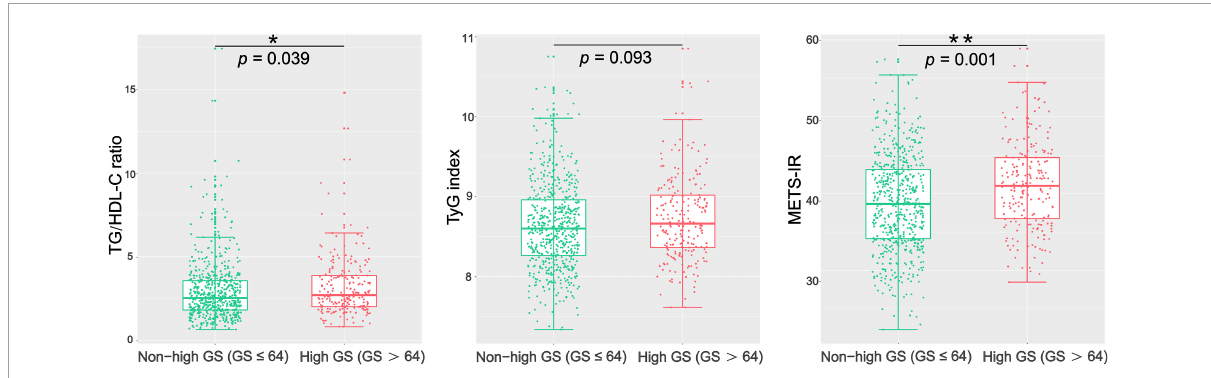
FIGURE1 Comparison of the TG/HDL-C ratio, TyG index, and METS-IR between the high GS group and the non-high GS group. GS, Gensini score; TG/HDL-C ratio, the ratio of triglycerides to high-density lipoprotein cholesterol; TyG index, triglyceride and glucose index; METS-IR, metabolic score for insulin resistance. * p < 0.05; ** p < 0.01.